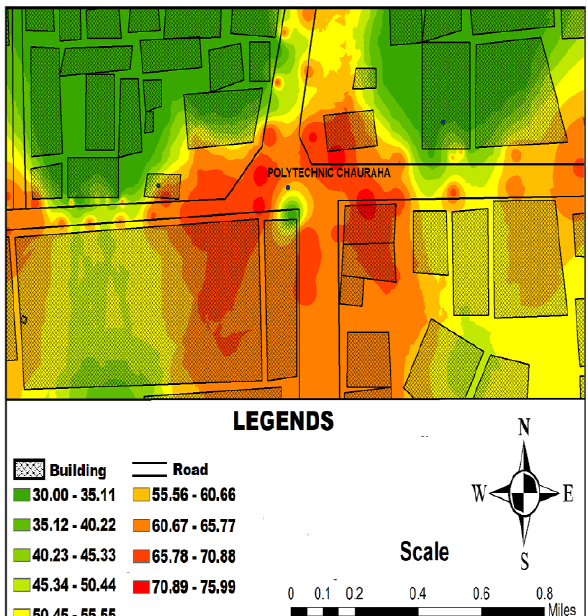
Figure 2. Noise map of Polytechnic Chauraha afternoon slot with value variation is between 30.00 to 75.99. Barrier and distance attenuation is also calculated and